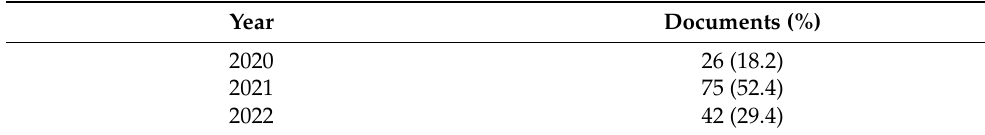
Table 1. Year-wise distribution of SARS-CoV-2 S protein structures